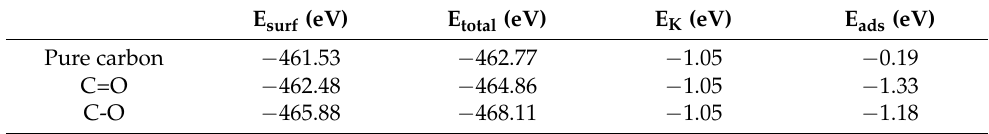
Figure 5. Deformation charge density maps of ( a ) pure carbon, ( b ) C-O, and ( c ) C=O and the corre- sponding side views. Figure 6. DOS for pure carbon, C=O-doped carbon, and C − O − doped carbon. Finally, Figure S6 depicts the K storage mechanisms of OPDC. In the high-potential slope area, the surface Faraday reaction between the C=O group and K-ions plays an im- portant role in K storage, as well as the adsorption of K-ions at the defects. The surface induction characteristics mainly provide high capacitance and fast kinetics. In the low-